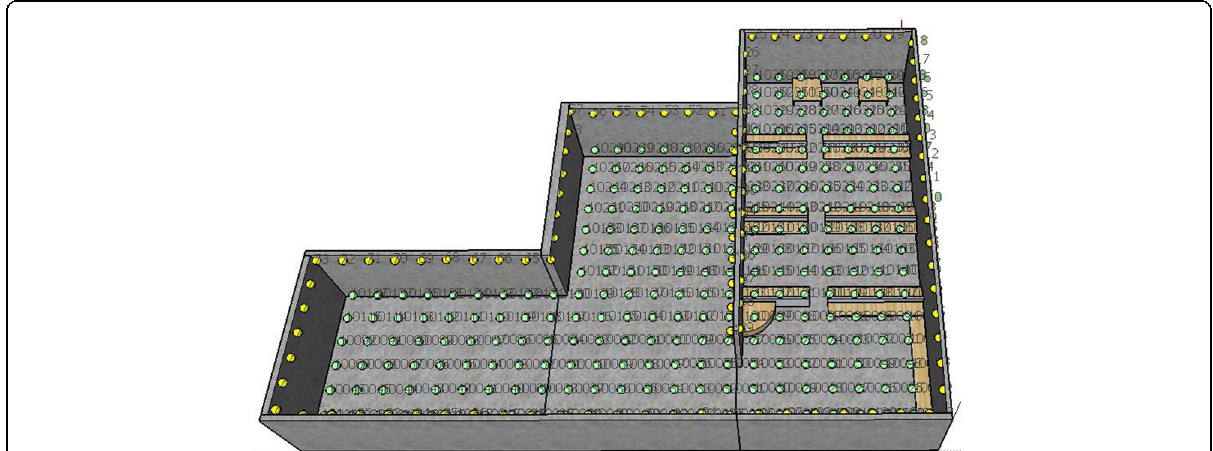
Fig. 1 Simulation optimization scenario. In the simulation experiment of network element layout, the experimental scene was set as a “ double L ” region, with a total length of 24.1 m and a width of 17.8 m. According to the actual situation, select 3 m from the ground height to divide the 1 m × 1 m grid. A location near the wall was selected as the deployment of base station, a total of 102 locations for network deployment. The selected position of the terminal is 1.2 m away from the ground, and the 3D grid of 1 m × 1 m × 1 m is divided. Two hundred sixty-four terminals are located at the center of gravity of the grid. The yellow dot indicates the network element location to be installed and the green dot indicates the user terminal location